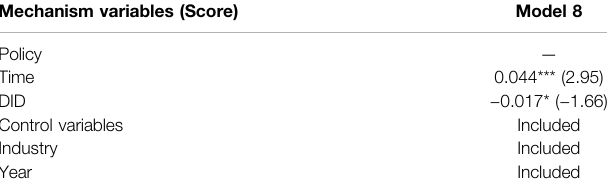
TABLE 6 | Mechanism test regression